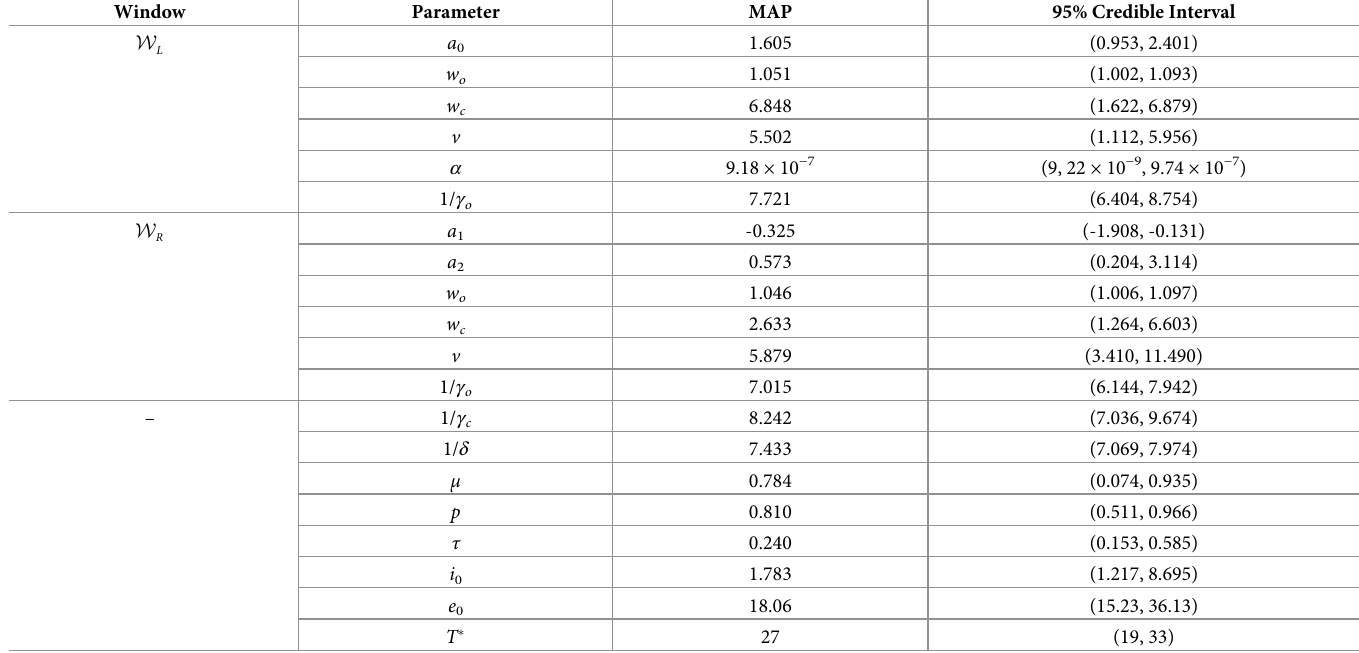
Table 4. MAP estimates and associated credible intervals for Sarawak.